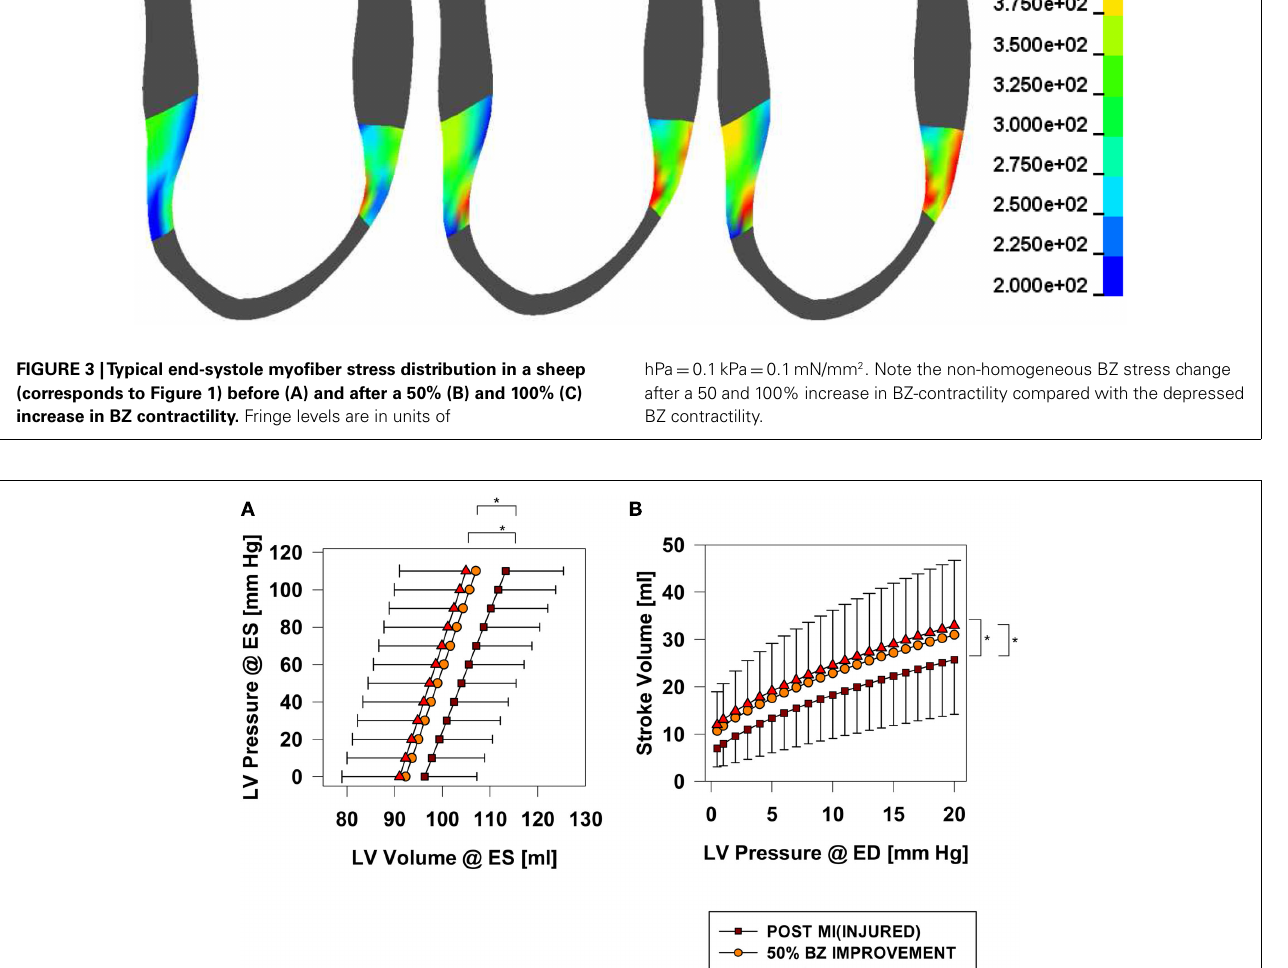
FIGURE 4 | End-systolic pressure volume (A) and Starling relationships (B) before and after an increase 50 and 100% in BZ contractility. *Signifies p < 0.001.